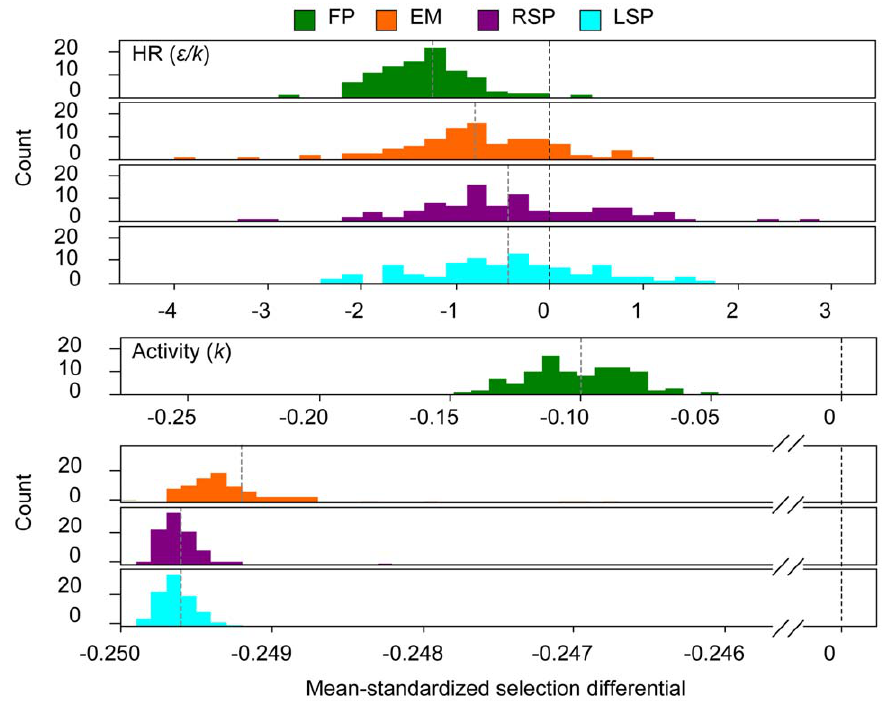
Figure 4. Distribution of mean-standardised selection differentials on the mathematical descriptors of movement. Frequency distributions ( n =100) of the mean-standardised selection differentials ( S m ) calculated in each iteration for each movement characteristic (radius of the HR and the activity approximated by K ) in the different fisher styles (left panels). Black dashed vertical lines mark the level of no selection ( S m =0), and grey dashed vertical lines mark the mean- S m calculated for the 100 iterations performed for the different fisher styles: the fisher fixed in one spot (FP), the fisher moving in the edge of the scenario (EM), the random search pattern (RSP) and the Le´vy search pattern (LSP).